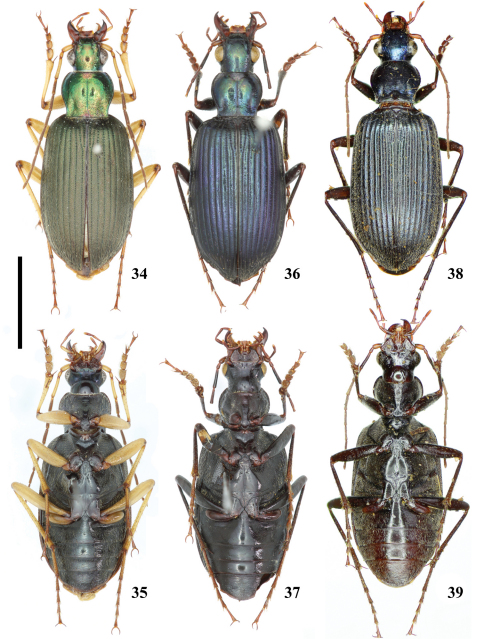
Chlaenius (Lithochlaenius) spp34 Chlaenius rambouseki Lutshnik, male, collected from Ussuri region, in IZCAS, dorsal view35 Chlaenius rambouseki Lutshnik, male, collected from Ussuri region, in IZCAS, ventral view36 Chlaenius anchomenoides Bates, cotype, male, in BMNH, dorsal view37 Chlaenius anchomenoides Bates, cotype, male, in BMNH, ventral view38 Chlaenius nuristanus Jedlička, paratype, male, in MNHN, dorsal view39 Chlaenius nuristanus Jedlička, paratype, male, in MNHN, ventral view. Scale line = 5.0 mm.